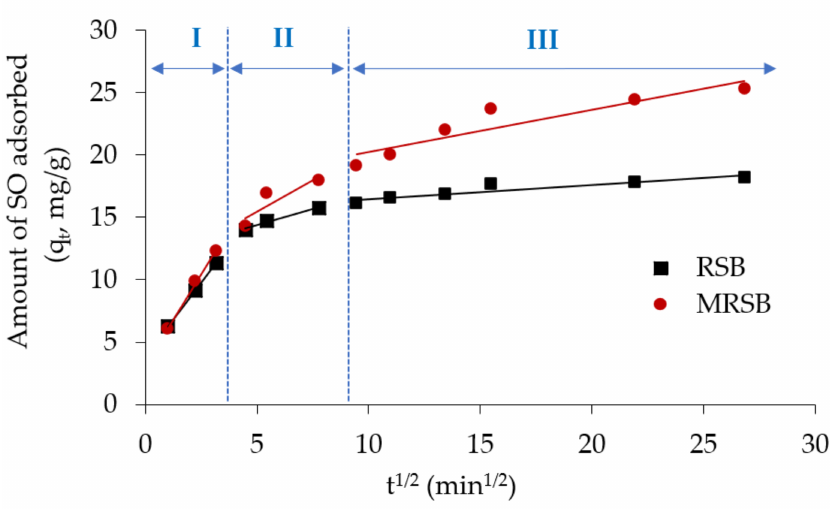
Figure 7. Intraparticle diffusion plots for adsorption of SO on MRSB and RSB (Experimental condi- tions: C 0 = 50 mg/L, m adsorbent = 2 g/L, t = 1–720 min, pH